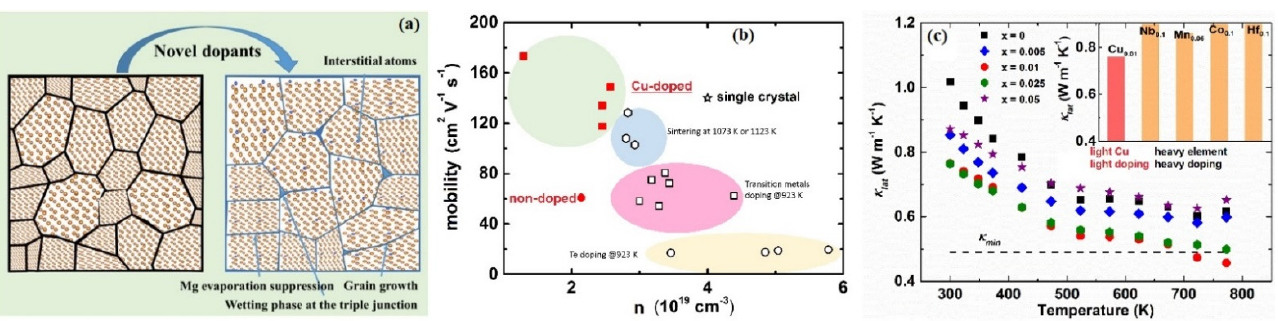
Figure 8. Minor Cu doping effect in Mg 3 Sb 2 ( a ) schematic, ( b ) mobility, ( c ) thermal conductivity